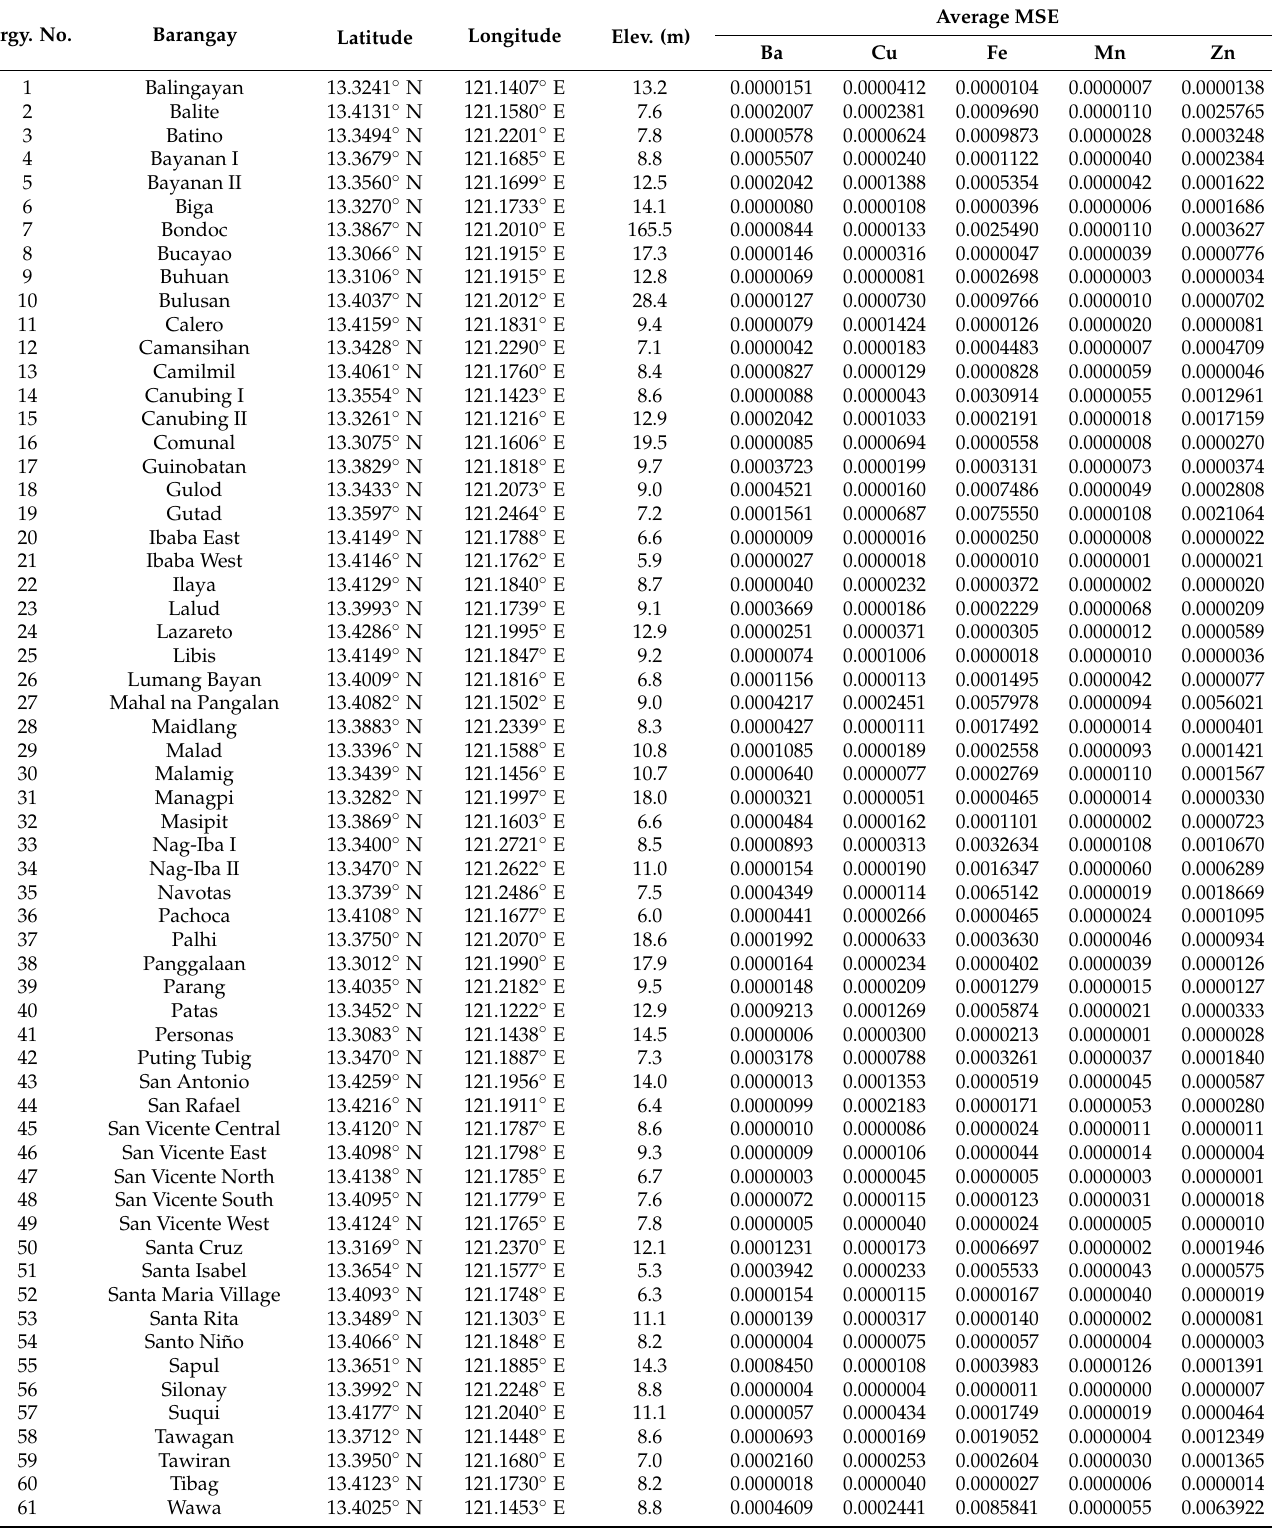
Table A2. Spot Sampling Results in each Barangay of Calapan